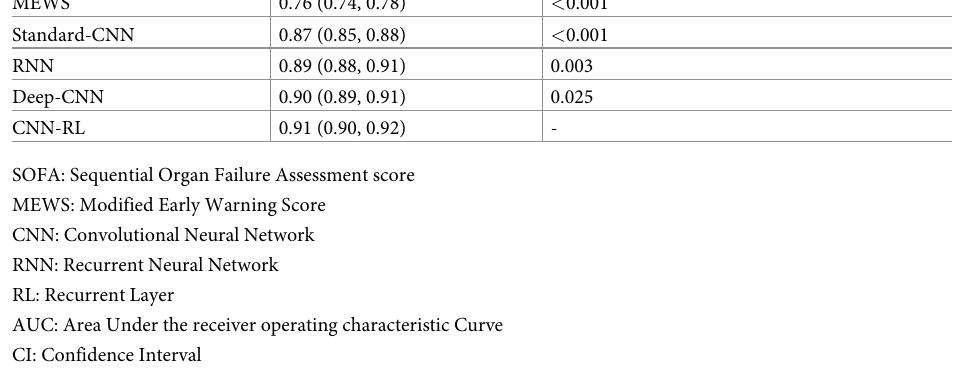
AUC: Area Under the receiver operating characteristic